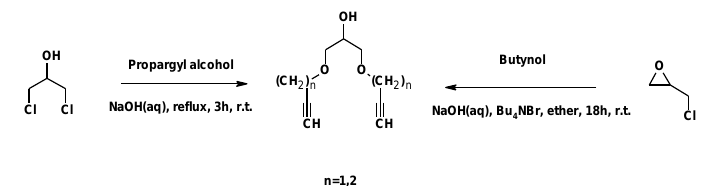
Figure 28. Synthesis of glycerol-type linking arms based on alkenyl motifs using DCH and ECH.